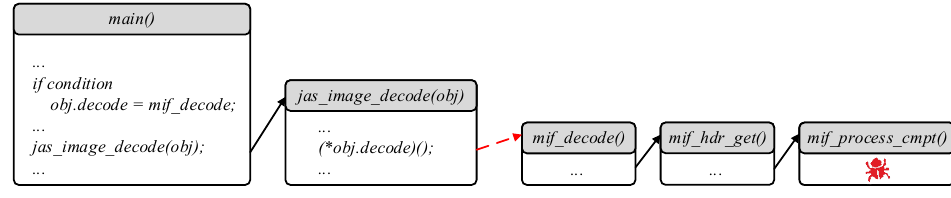
Figure 12. Example of updating the distance